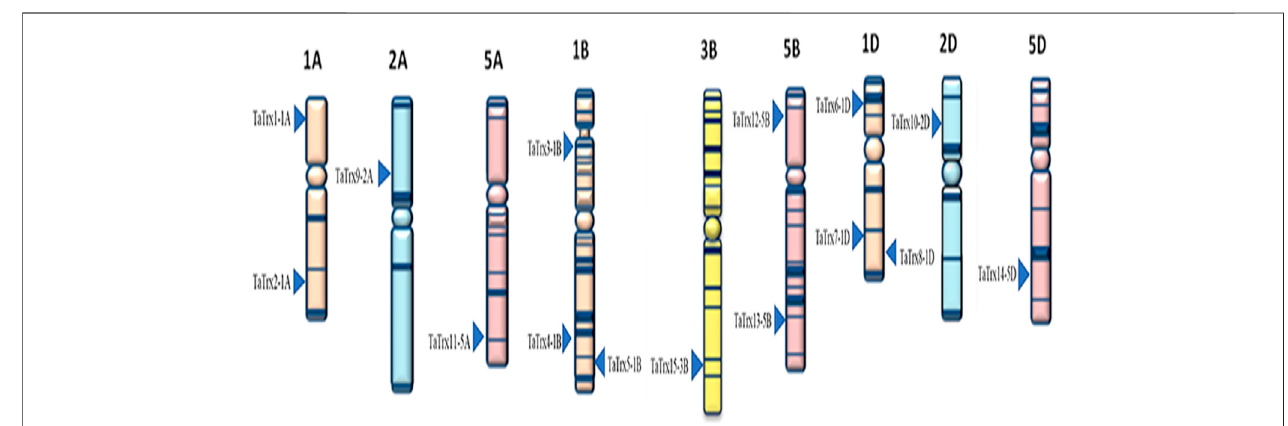
FIGURE2| Distributionoftheselected15TaTrxgenesacrosstheninechromosomesofgroupsA,B,andDsub-genomesofwheat.FiguretakenfromtheIWGSC website (https://www.wheatgenome.org/).